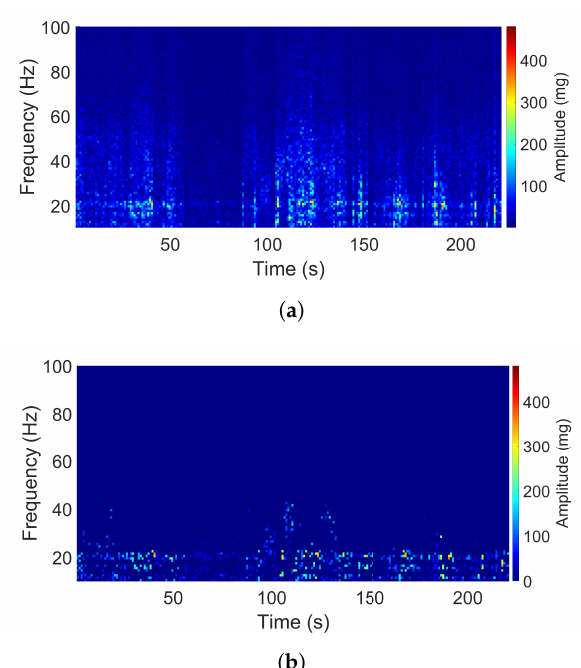
Figure 11. Spectrogram of the bike signal (Z direction): ( a ) Original. ( b )